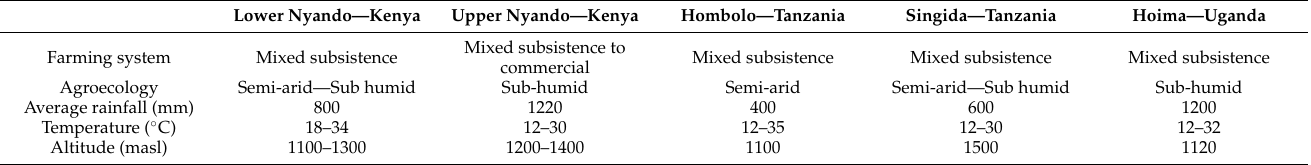
Figure 1. Selected study areas in East Africa ( A ) and survey sites in Kenya, Tanzania, and Uganda ( B ). Table 1. Geographical and farming characteristics of the study